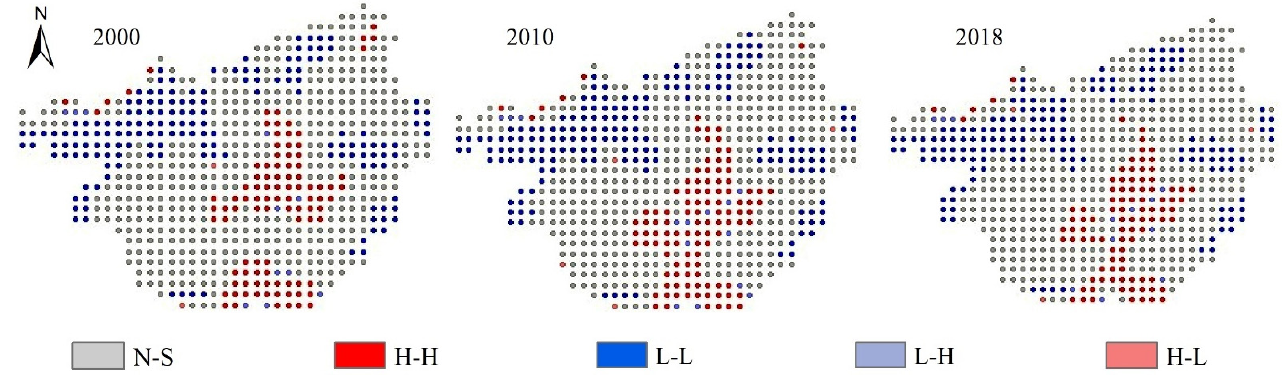
Figure 8. Local autocorrelation diagram of ecological risk.